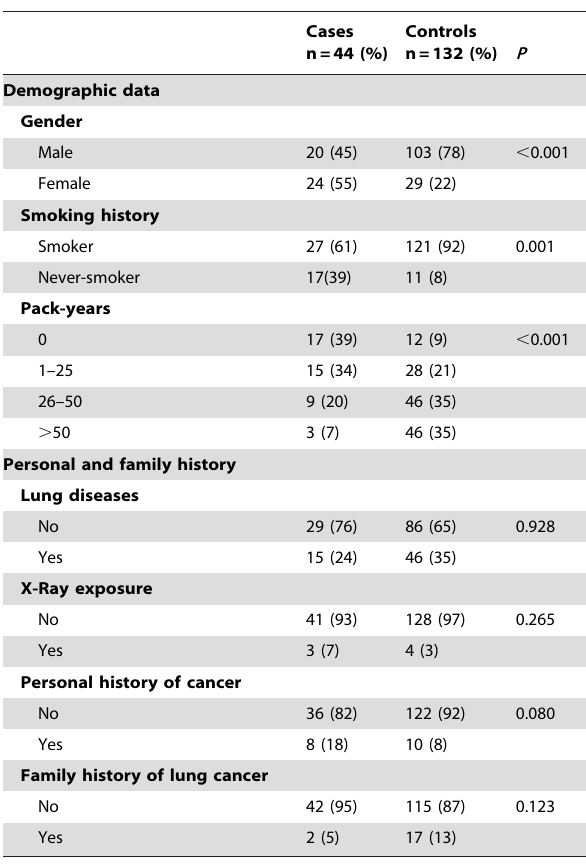
Table 1. Population characteristics.